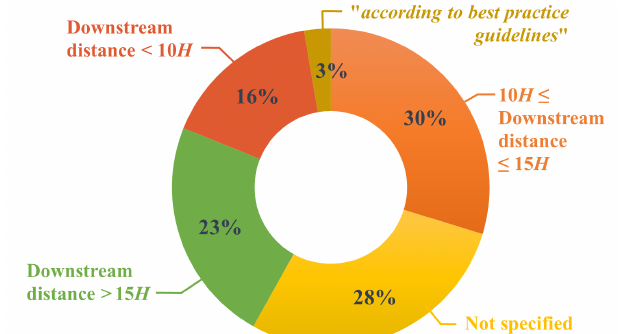
Figure 10. Downstream distance overview.